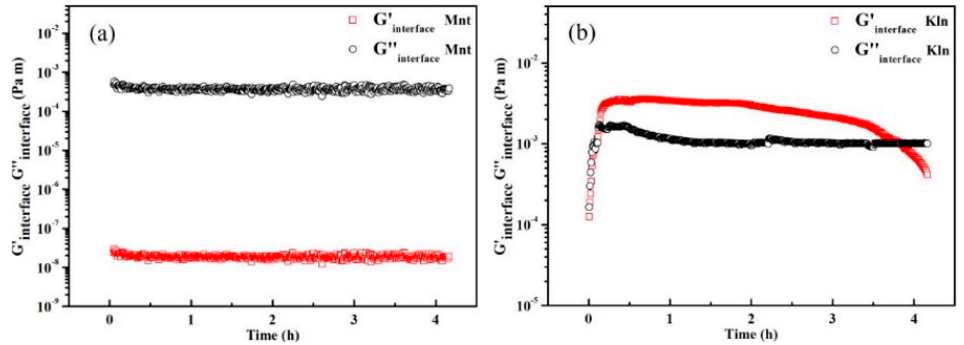
Figure 3. Oscillatory time sweep tests of clay–oil interface with 3000 ppm ( a ) Mnt and ( b ) Kln dispersed in saturates at 298 K.